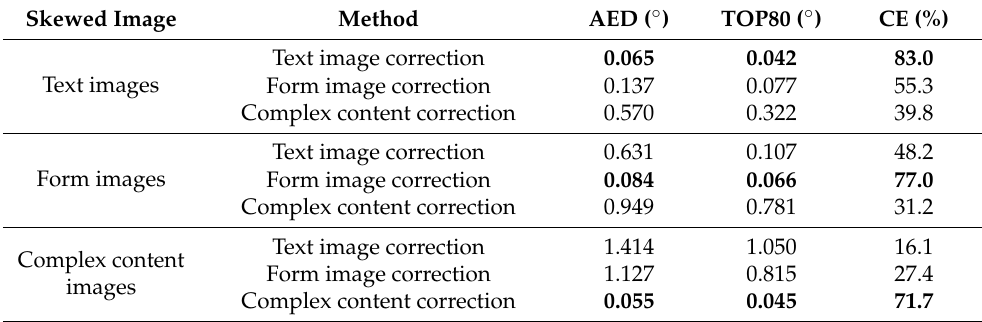
Table 2. Matching degree detection of three